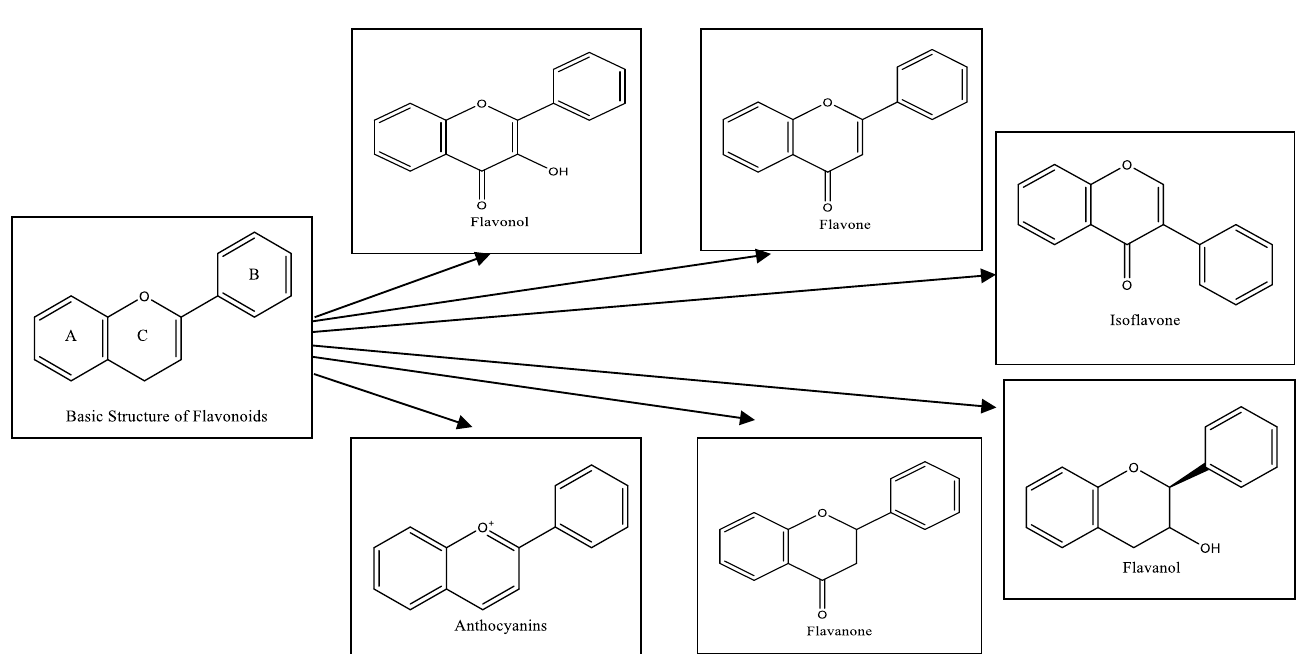
Figure 4. Flavonoids' basic chemical structures and